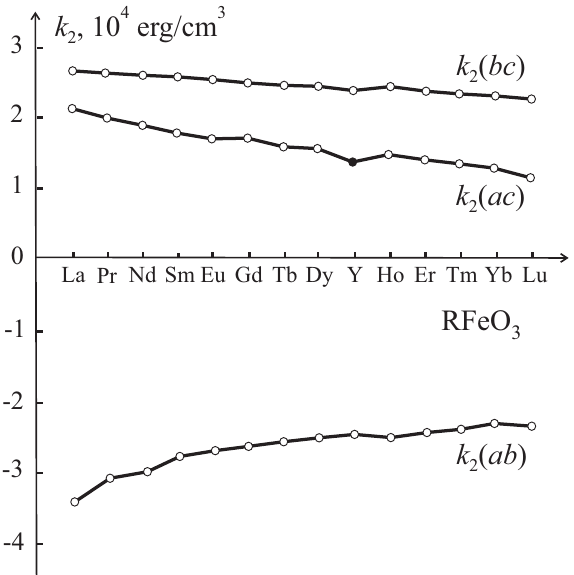
Figure 7. The YFeO 3 -normalized ( ac -plane) k 2 constants for